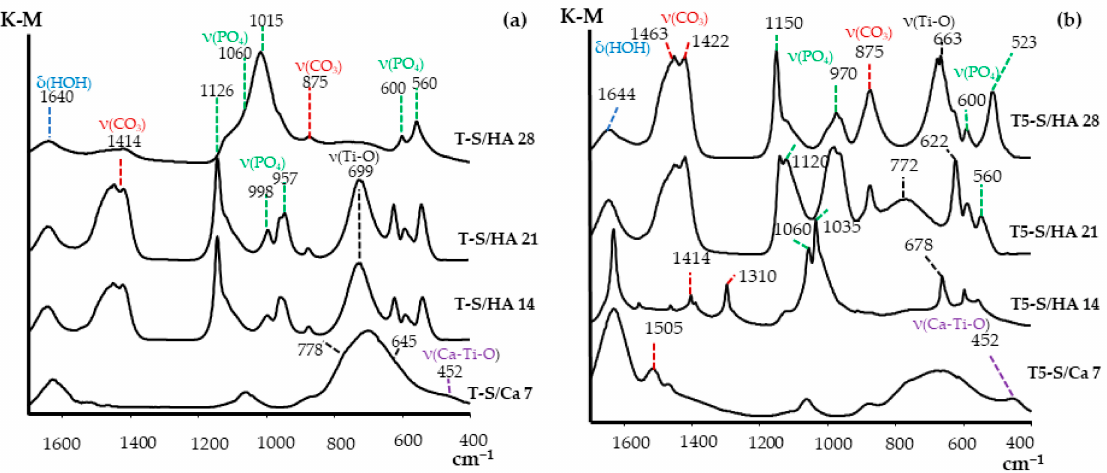
Figure 7. Diffuse reflectance infrared Fourier transform spectroscopy (DRIFT) spectra of studied T-S/Ca and T-S/HA ( a ) and T5-S/Ca and T5-S/HA ( b ) after immersion in SBF for 7, 14, 21, and 28 days.